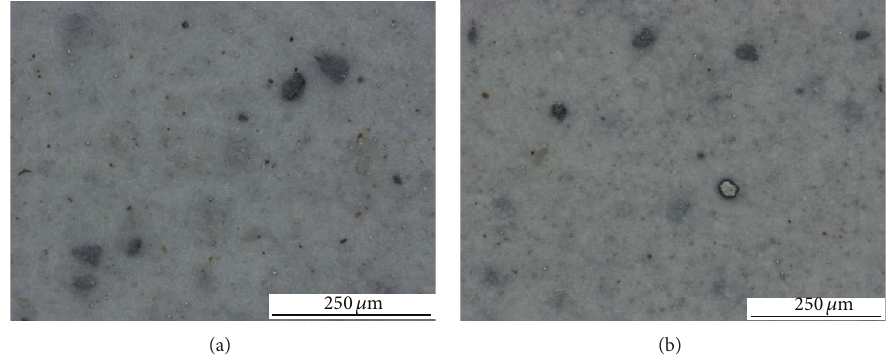
Figure 1: Micrographs of the studied painted samples before and after immersion test. (a) The studied painted samples before immersion. (b) The studied painted samples after immersion.